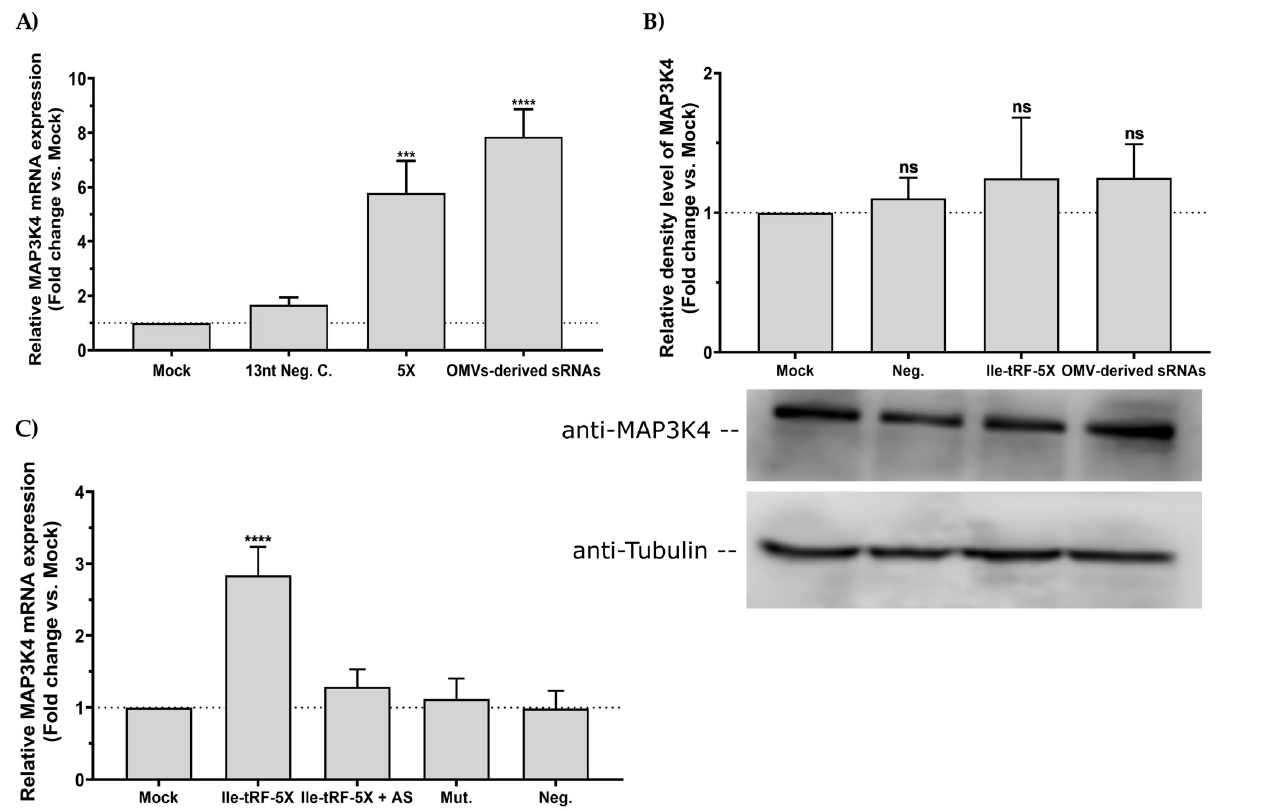
Fig 8. Bacterial Ile-tRF-5X upregulates human MAP3K4 expression in a sequence specific manner. ( A-C ) Human HCT116 cells were transfected with (100 nM) synthetic Ile-tRF-5X alone, mutated (Mut.) or combined with its antisense (AS), unrelated 13-nt negative control (Neg.) or small RNAs (sRNAs) derived from bacterial OMVs. ( A ) and ( C ) Relative quantification of MAP3K4 mRNA expression by RT-qPCR. Data were normalized with a reference gene (ACTB), reported as fold change vs mock control, and expressed with the relative quantitation method ( ΔΔ Ct). ( B ) Western blot analysis of MAP3K4 protein expression relative to tubulin. Densitometric analysis of the bands was performed with ImageJ. Data were normalized with a reference gene (tubulin) and expressed as fold change vs mock control. Statistical analysis . Data were calculated from three biological replicate measurements (n = 3; mean ± SD). One-way analysis of variance (ANOVA) and Holm-Sˇı´da´k’s multiple comparisons test (post hoc test) were used for statistical analysis. Statistically significant differences are indicated as follows: ��� p < 0.001, ���� p < 0.0001. ns, not significant.